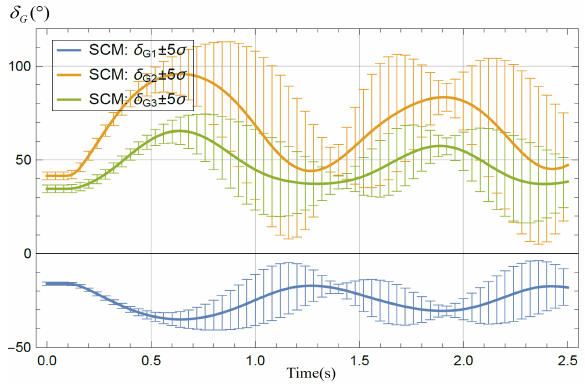
Figure 6. Expectation and standard variance of rotor angles in fault 1.